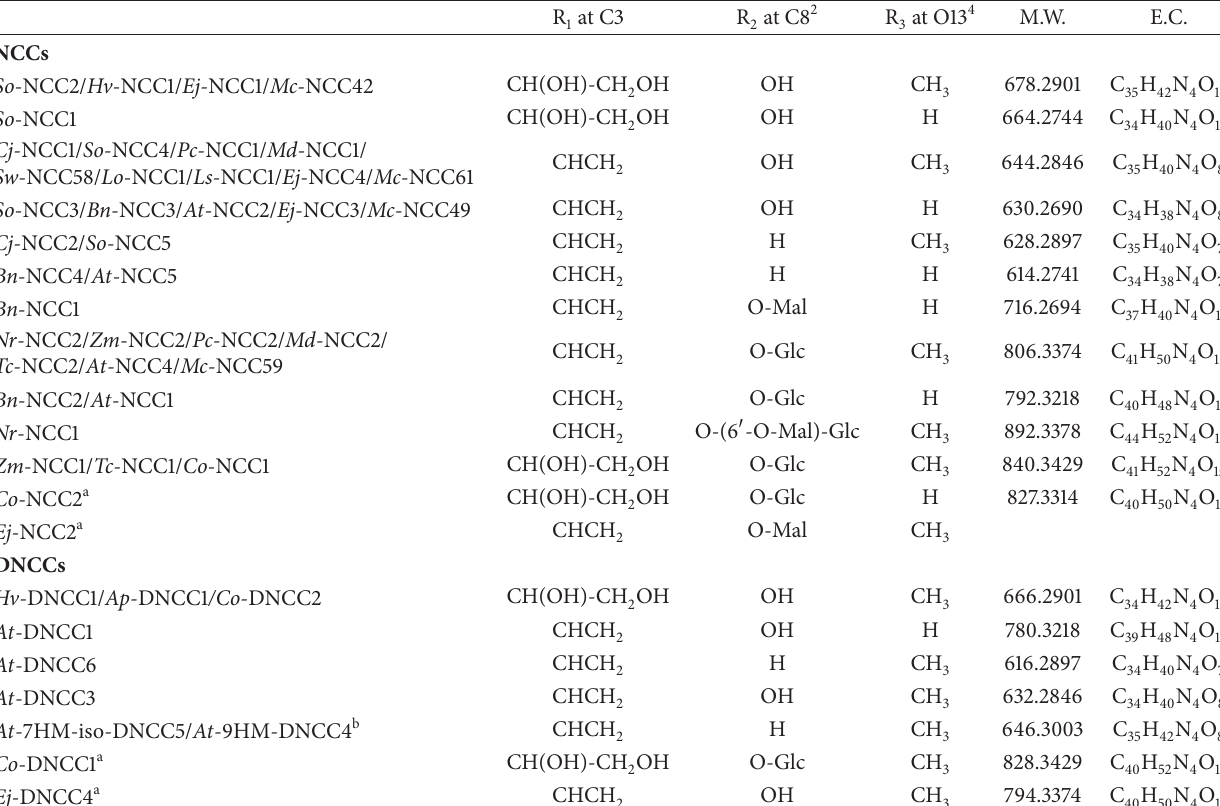
Table 1: In-house database of known NCCs and DNCCs built for screening chlorophyll catabolites in vegetal tissues.